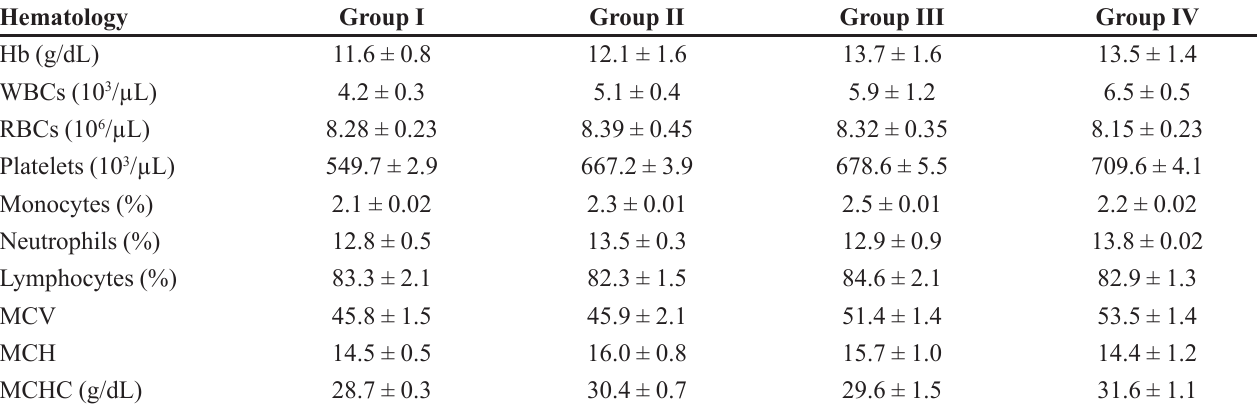
TABLE III - Biochemical blood analysis of control and LSH treated